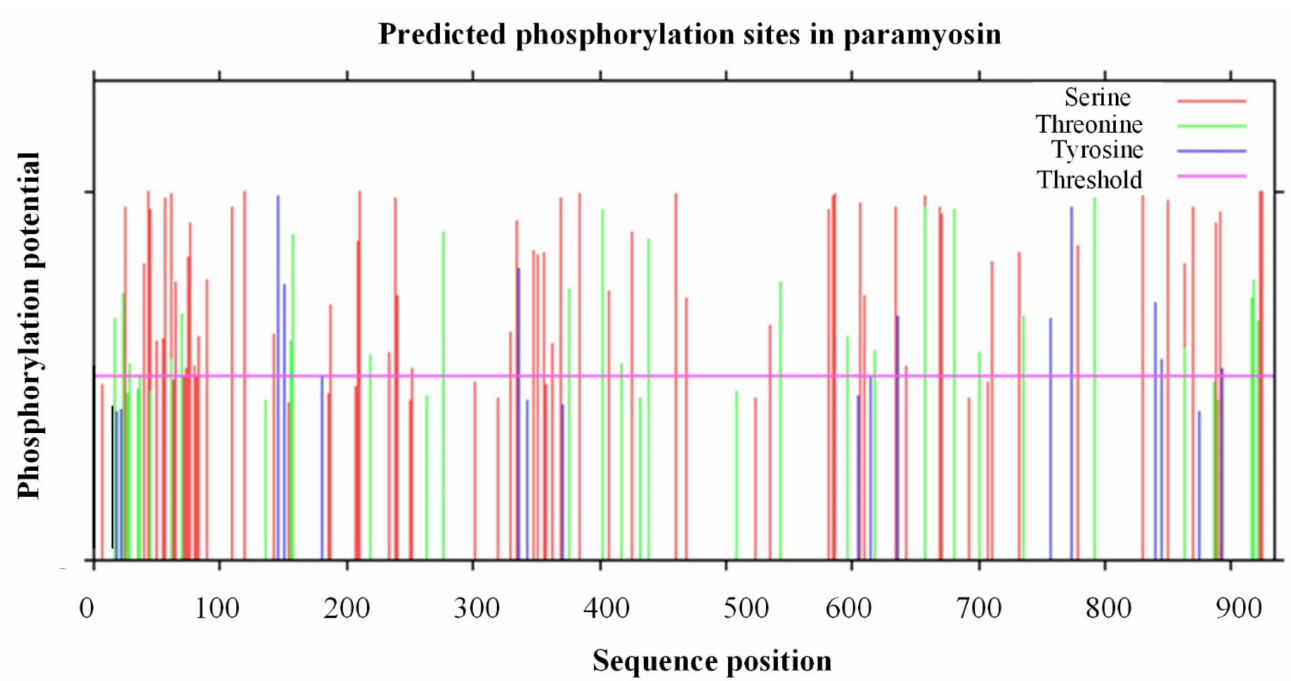
Figure 3. All the potential phosphorylation sites identified in paramyosin of P. yessoensis using NetPhos